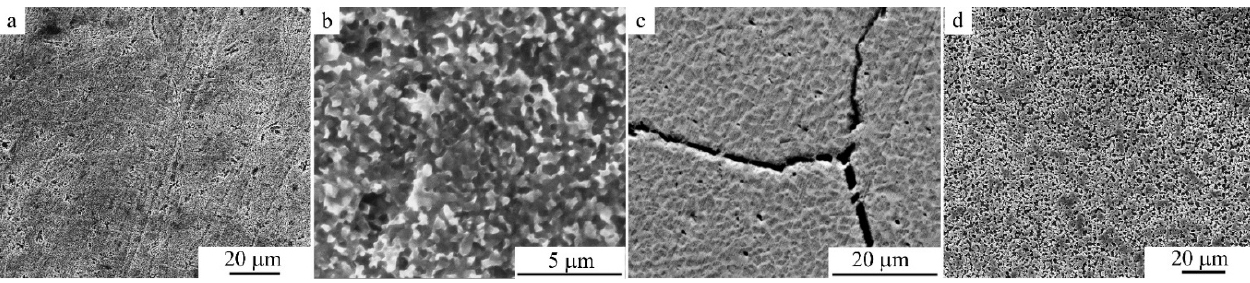
Figure 23. SEM images in SE mode of the intragrain microstructure in the Cu-14Al-4Ni alloy after the compression tests at 673 K (( a )— v = 5, ( b , c )— v = 1, ( d )— v = 0.5 mm/min) [47].